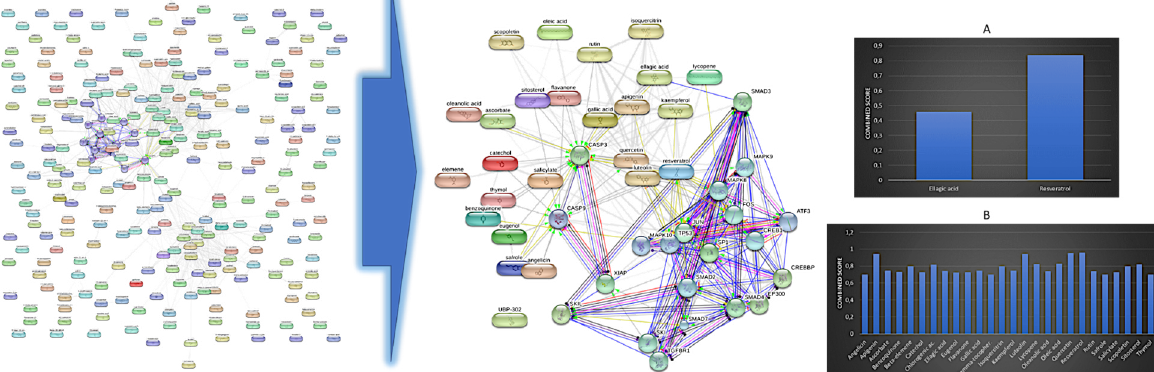
Figure 2. Chemical-protein interaction network, showing the possibilities of interactions between bioactive chemical compounds from Brazilian plants and the CASP3 and SMAD3 leader genes. The network was expanded to show the leader genes and their interactions with bioactive plant compounds. Graphs a and b show the combined scores of the bonds of the chemical compoundswi th the SMAD3 and CASP3 genes,